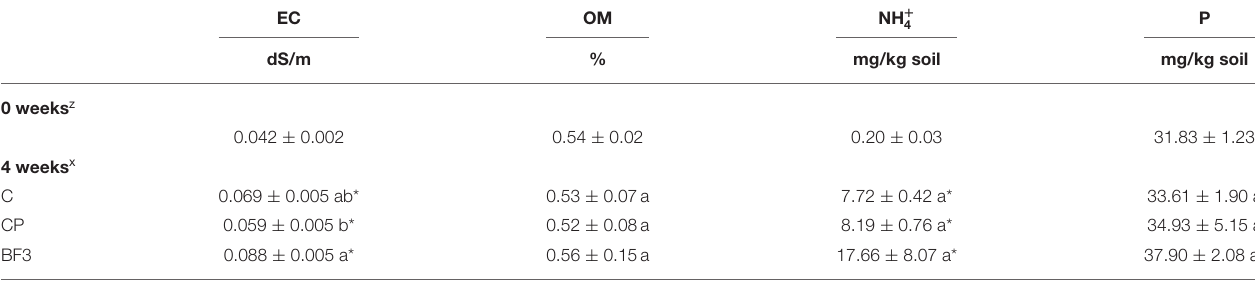
TABLE 1 | Soil properties before Brassica carinata pellets incorporation (0 weeks) and at the end of the treatments in the field experiment (4 weeks).